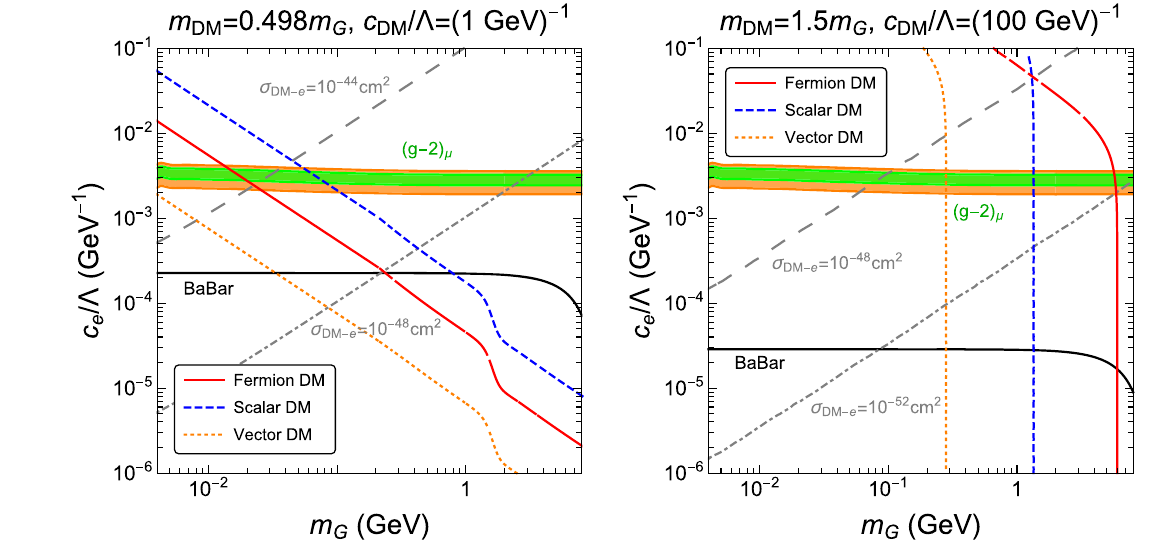
Fig. 8 Experimental constraints on c e /(cid:3) vs m G . The correct relic density is obtained along in red solid, blue dashed and orange dot- ted lines for fermion, scalar and vector dark matter, respectively. The ( g − 2 ) μ favored region at 1 σ or 2 σ is shown in green and orange, respectively. Invisible and visible searches at BaBar rule out the region